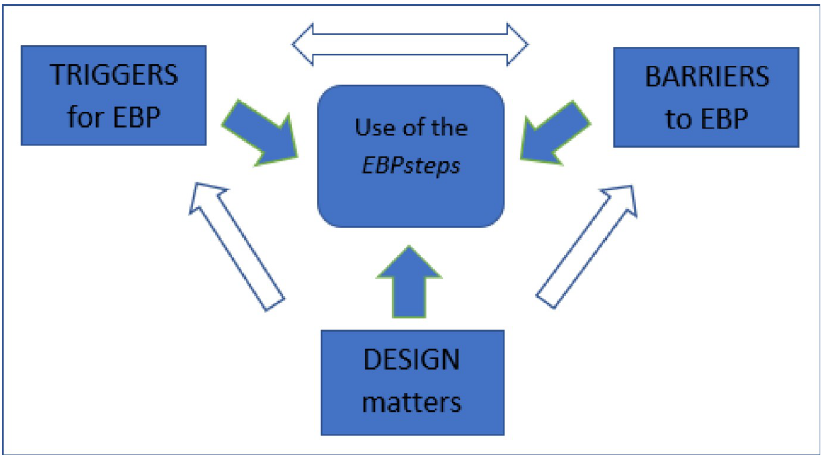
Fig 2. Patterns and themes related to use of the EBPsteps